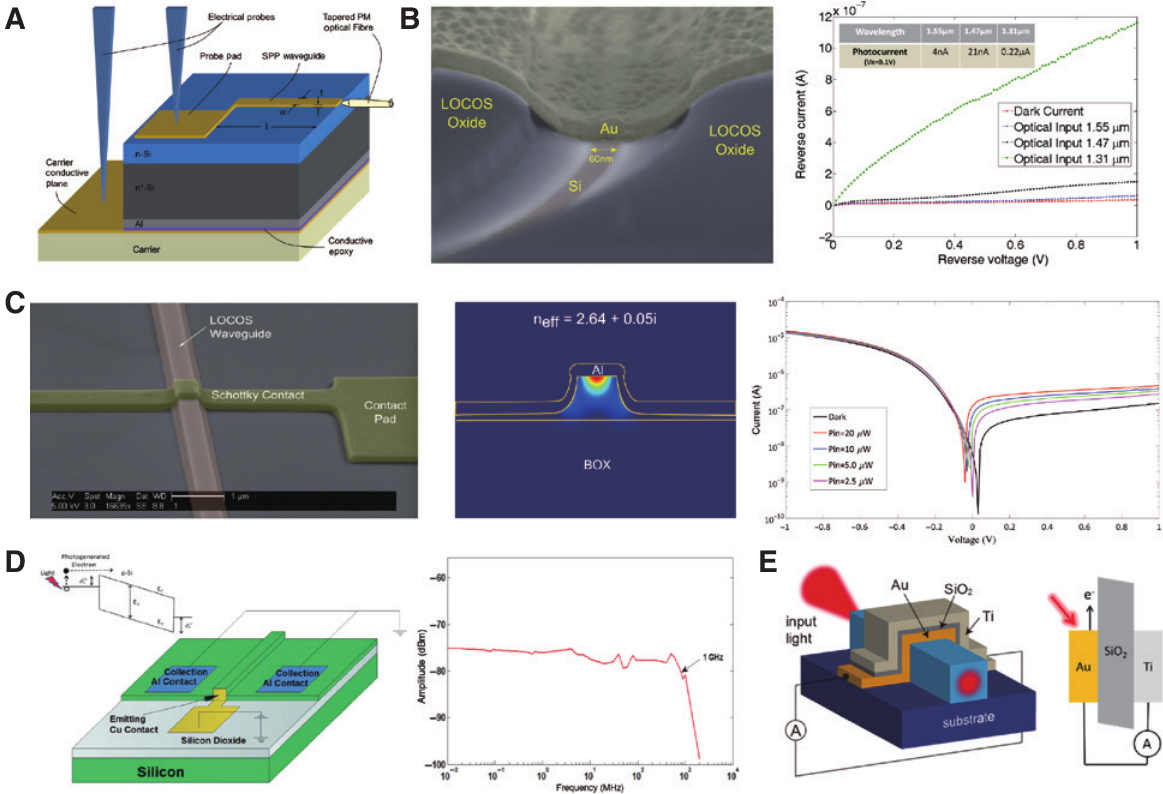
Figure 4: On-chip hot electron photodetectors. (A) Schematic of the SPP photodetector. Light is coupled to a SPP waveguide with optical fiber. One metal contact is connected to the SPP waveguide and the other is connected to the bottom of the semiconductor. (B) Left: SEM image of the locally oxidized silicon bus waveguide integrated with the Schottky photodetector. Right: Photocurrent as a function of reverse voltage for three different wavelengths. (C) Left: SEM image of the photonic bus waveguide integrated with the Schottky photodetector. Middle: Intensity mode profile of the waveguide. Right: Photocurrent as a function of reverse voltage and illumination power. (D) Left: Schematic of the Cu/Si photodiode, with metal contact on the vertical output facet of the waveguide. Right: Experimental frequency response of the detector showing up to 1 GHz